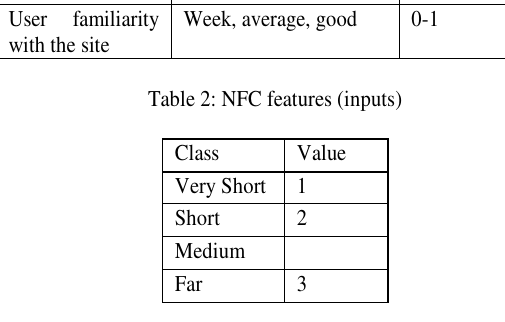
Table 3: NFC Classes